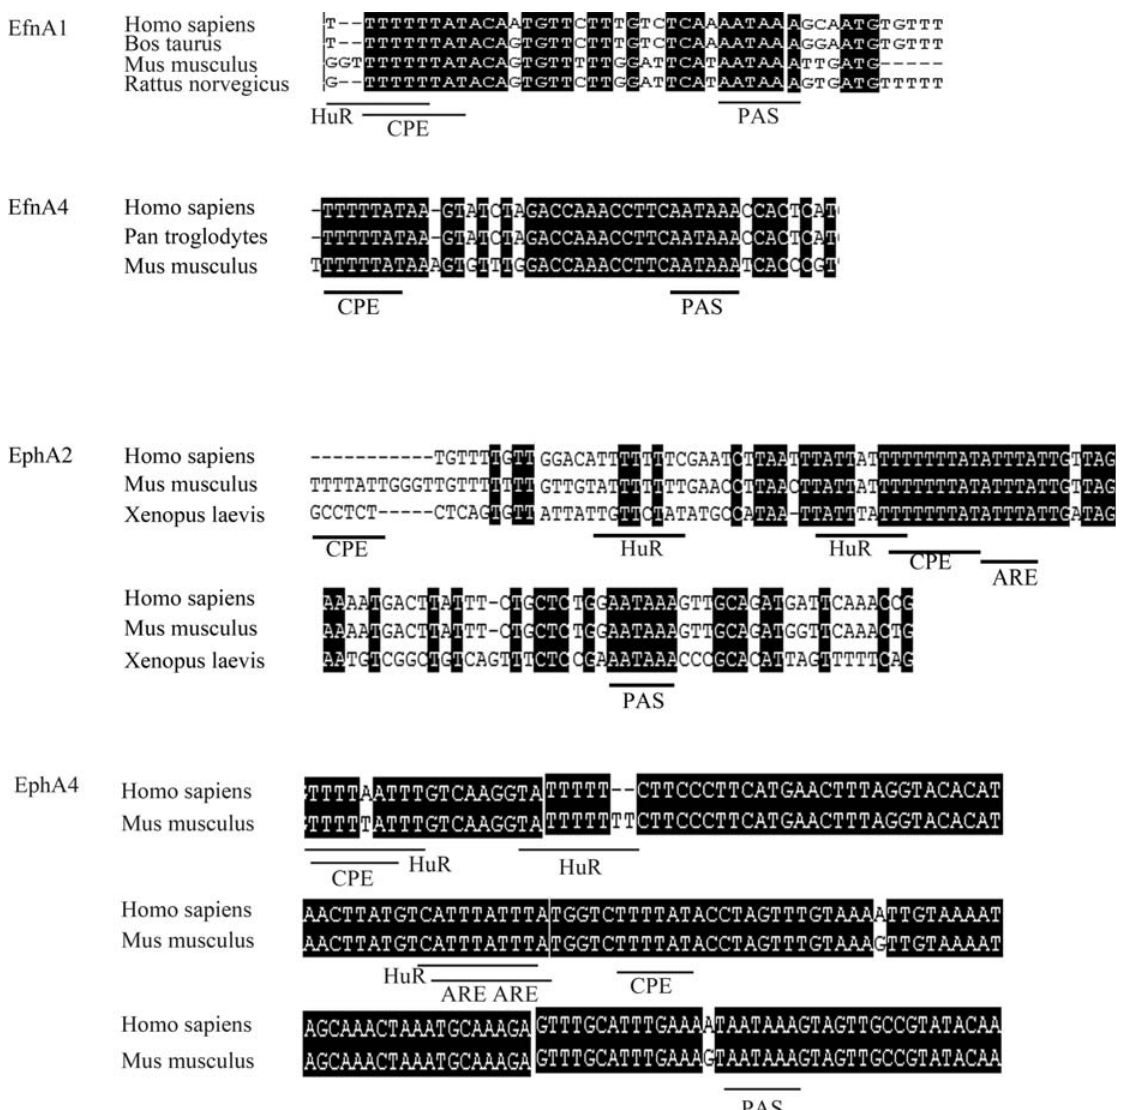
Figure 2. Conservation of 3’terminal parts of Eph/ephrin 3’UTRs containing clustered motifs. Multialignments of representative examples of clustered motifs as found in the 3’terminal parts of the EfnA1, EfnA4, EphA2 and EphA4 3’UTRs. Positions of CPEs, AREs, HuR binding sites as well as the consensus hexamer of the polyadenylation signal are indicated below the alignments.